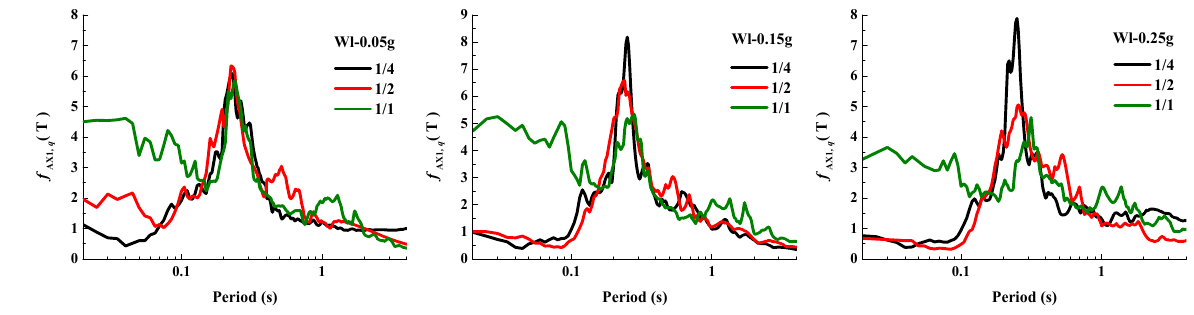
Figure 19. Transfer functions of measuring point AX1 under scaled Wolong